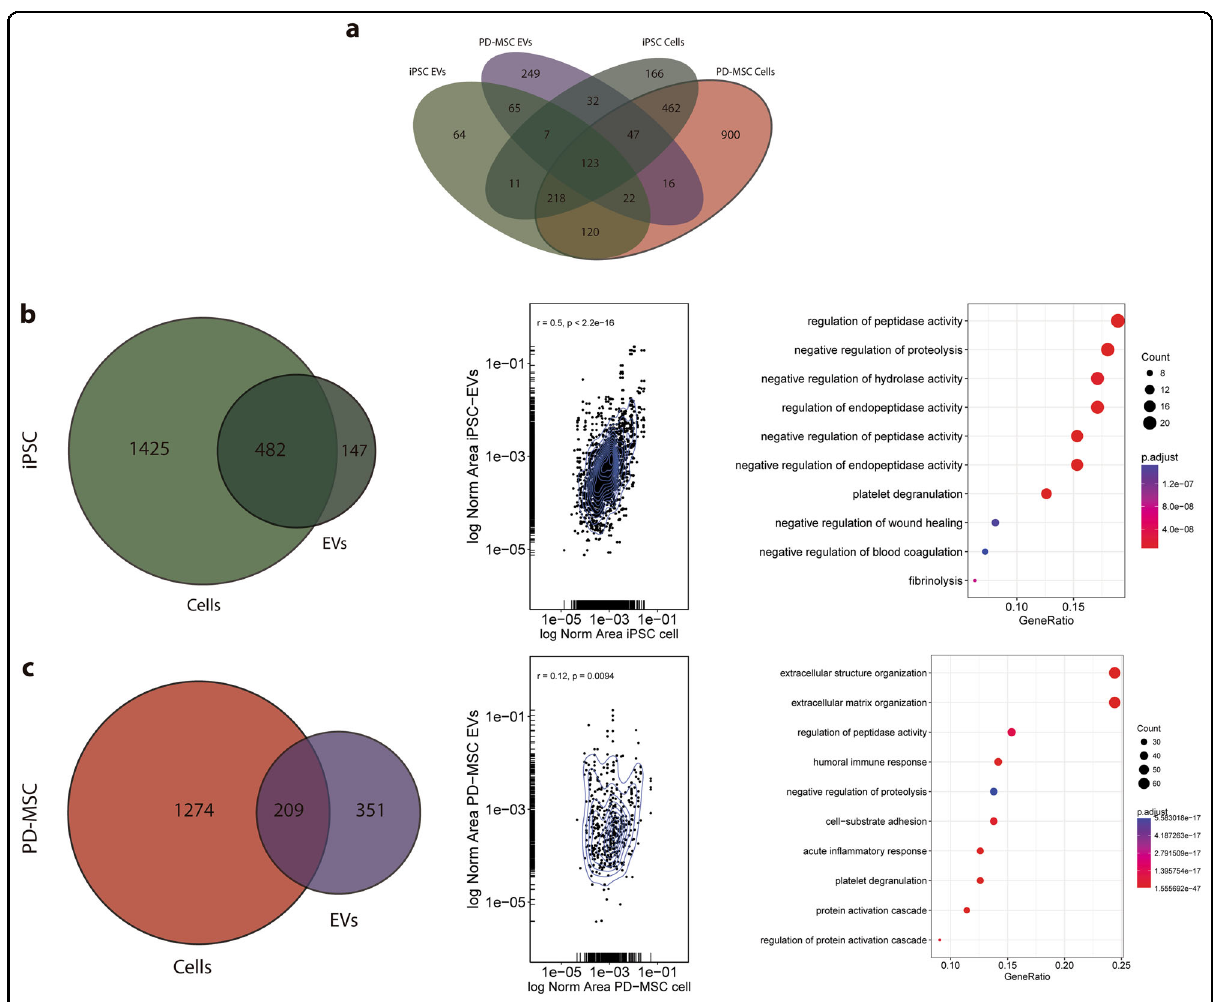
Fig. 3 Comparison between EVs and the cells that secreted them. a QuadVenn diagram of UniProt IDs identi fi ed by LC-MS/MS. b , Left panel: Venn diagram of UniProt IDs of iPSCs versus their EVs. Middle panel: scatter plot of relative abundance of shared proteins between iPSCs and their EVs. Right panel: Enriched Gene Ontology analysis (Biological Process) of iPSC EV exclusive proteins. c , Left panel: Venn diagram of UniProt IDs of PD- MSCs versus their EVs. Middle panel: scatter plot of relative abundance of shared proteins between PD-MSCs and their EVs. Right panel: Enriched Gene Ontology analysis (Biological Process) of PD-MSC EV exclusive